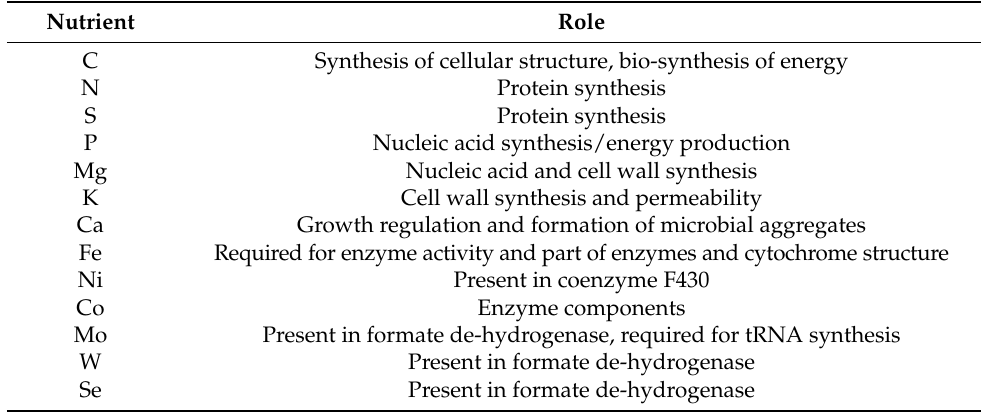
Table 1. Role of macro- and micronutrients in methanogenic